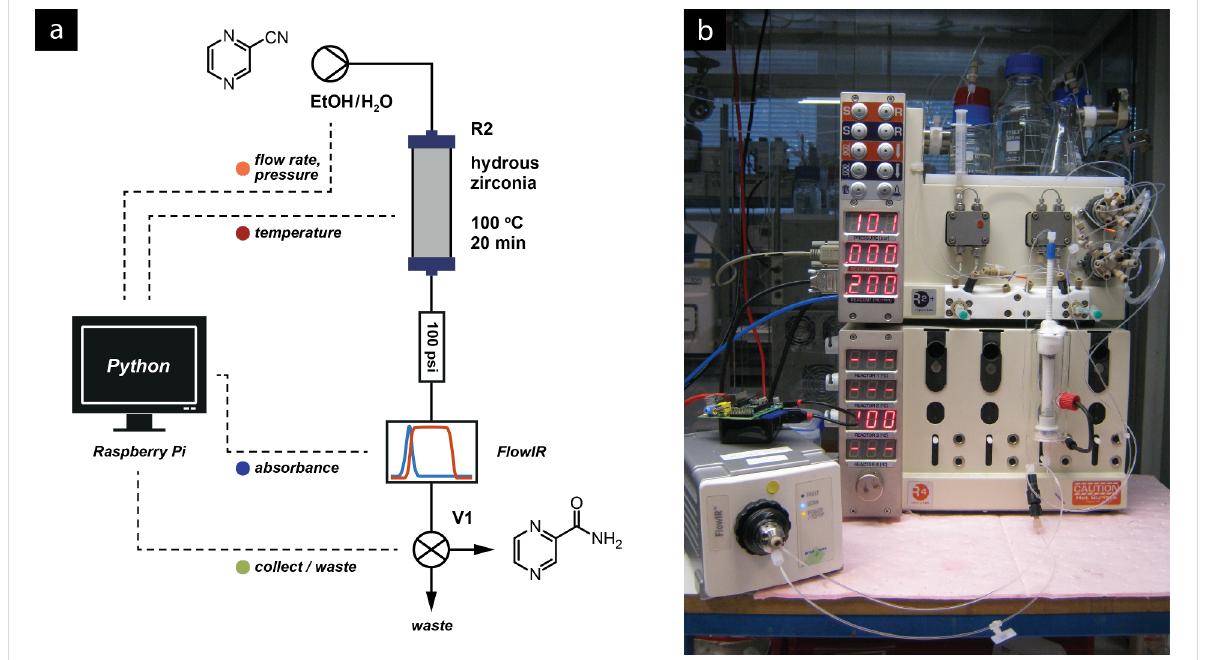
Figure 5: (a) Fluidic setup for the zirconia catalysed hydration of aromatic nitrile. (b) Raspberry Pi ® microcomputer, FlowIR spectrometer and Vapourtec R2+/R4 reactor unit as used for this procedure.